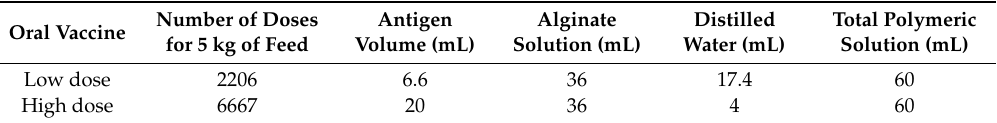
Table 2. Characteristics of polymeric solutions used to prepare experimental oral vaccines containing alginate-encapsulated Piscirickettsia salmonis antigens